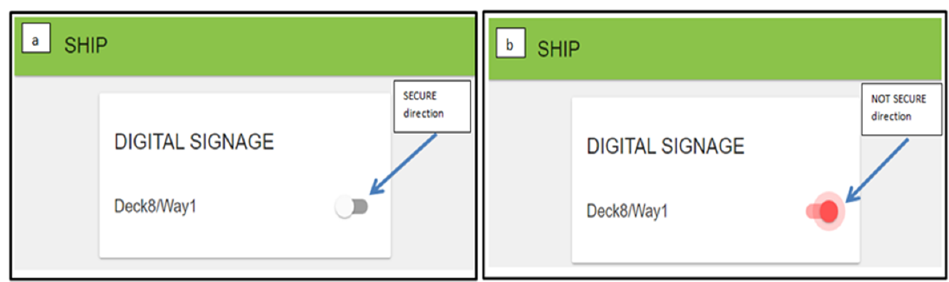
Figure 9. “Deck 8” experimental flow.